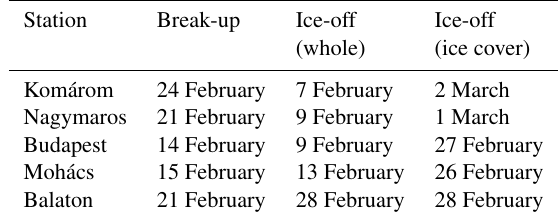
Table 2. Earliest, mean, and latest dates of the studied ice phenom- ena on the Danube and Lake Balaton recorded between 1885 and 2017.